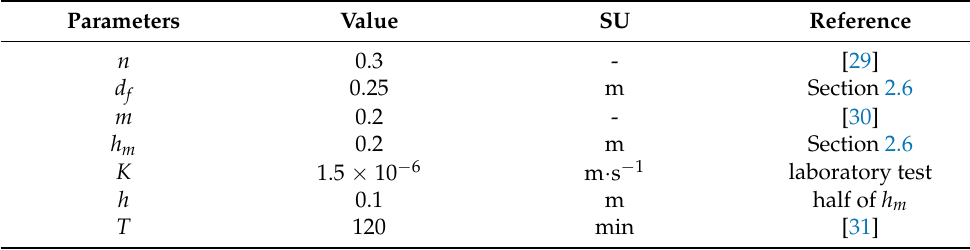
Table 1. Parameters selection and reference of Equations